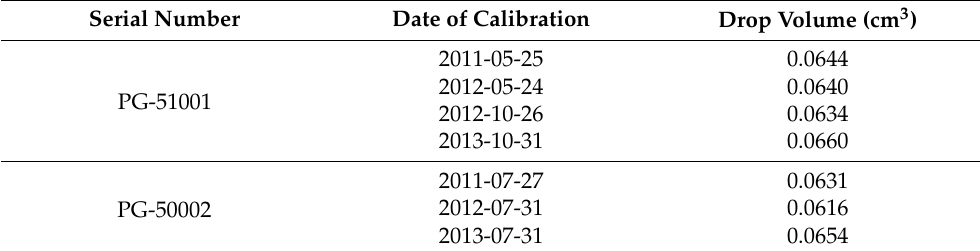
Table 2. Calibration date and associated drop volume for the two OSC gauges installed at the HKIA field test